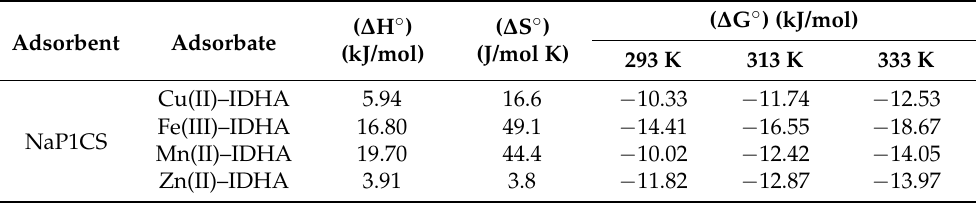
Table 6. Thermodynamic parameters for sorption of Cu(II), Fe(III), Mn(II), and Zn(II) complexes with IDHA onto NaP1CS.